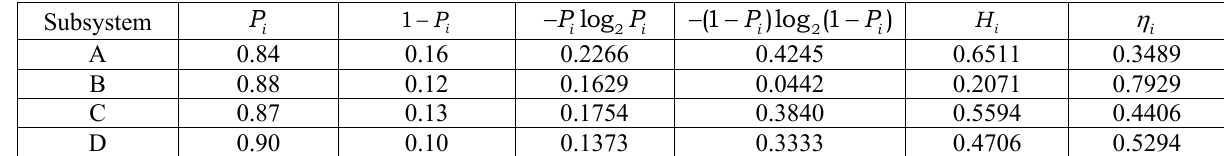
Table 1. Calculation of the values of stability of technology subsystems and the levels of its integrity Subsystem